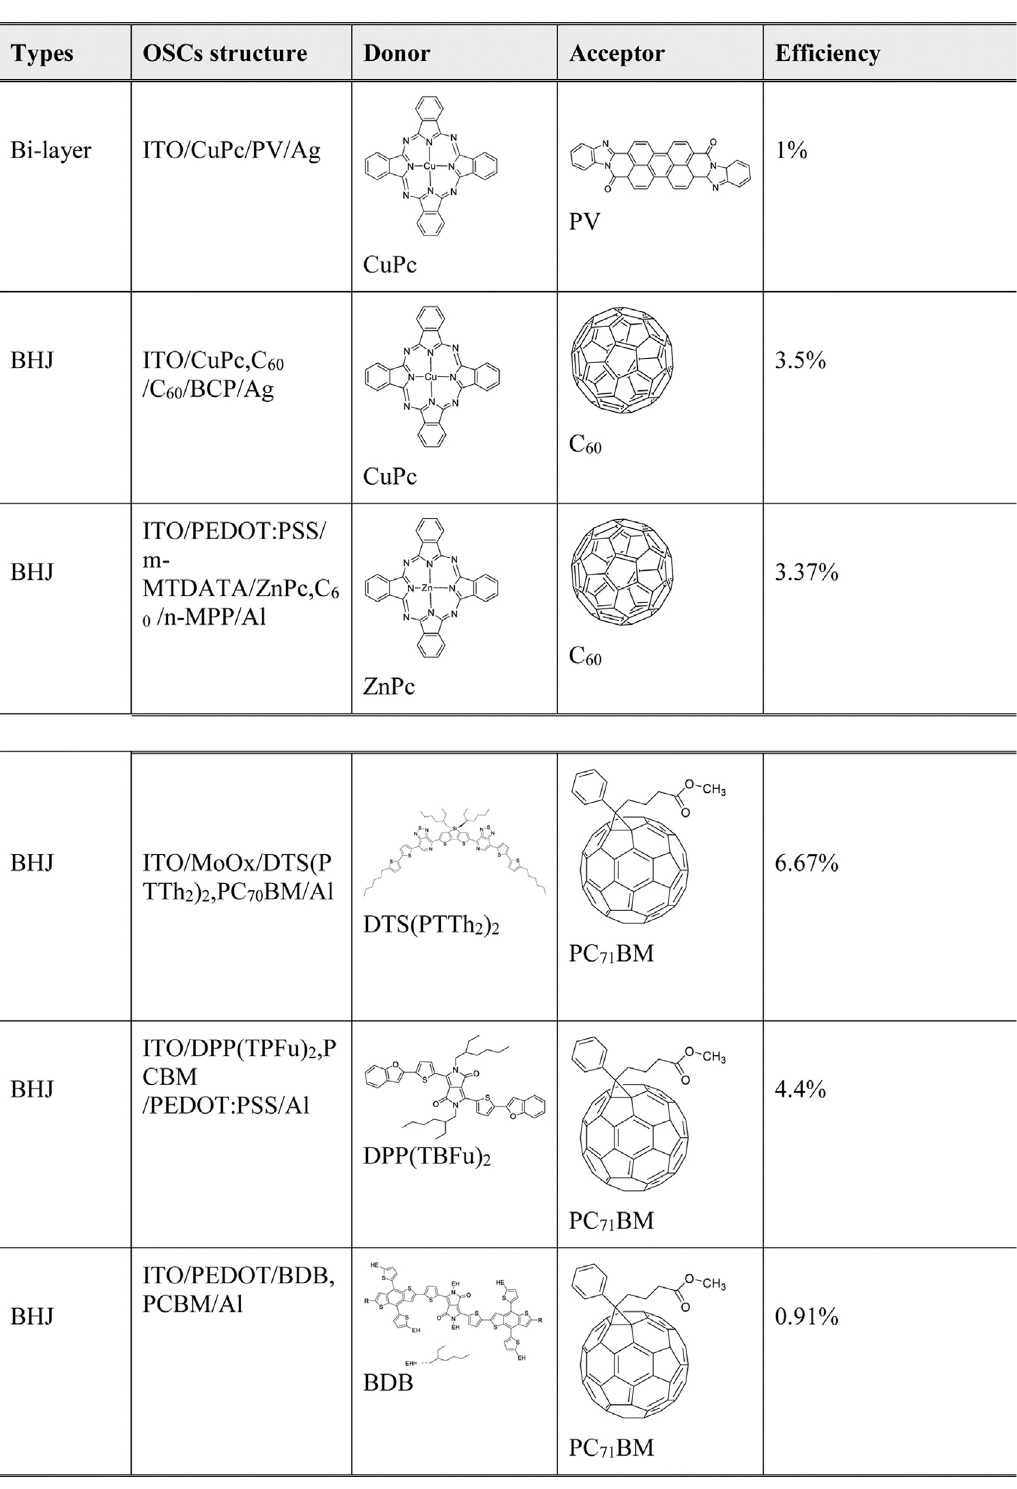
TABLE 3 | Small molecule based on fullerene and its derivatives used in organic solar cells and their structure.